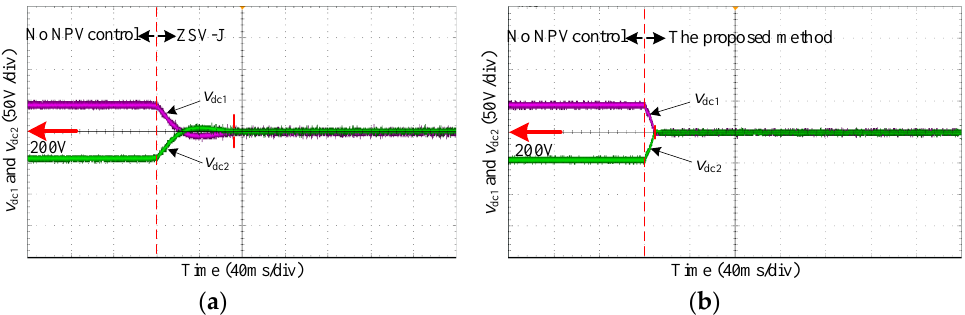
Figure 12. Performance comparisons of the two NPV control strategies when the two loads are unequal. ( a ) ZSV-J; ( b ) the proposed NPV control strategy.